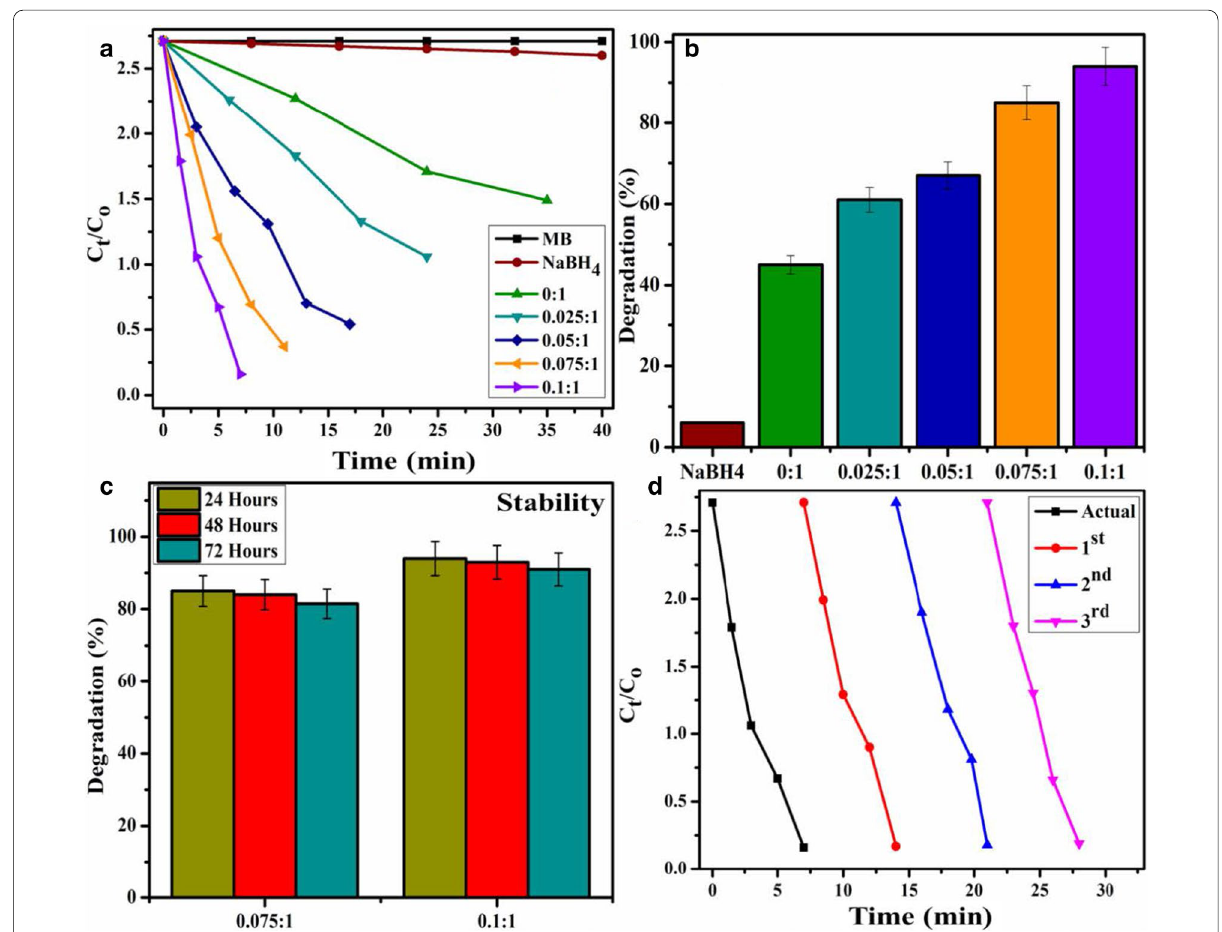
Fig. 7 a Plots of C t / C o versus time for all catalysts; b comparison of degradation percentage over various concentrations, c comparison of stability for 7.5 and 10 wt% Bi‑doped catalyst; d plot of C t / C o versus time for reusability of 10 wt% Bi‑doped BN catalyst